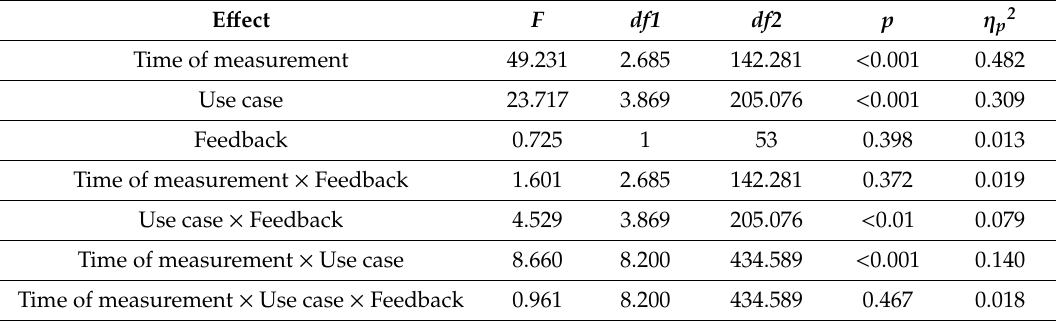
Table 6. Inferential statistics (i.e., F , df1 , df2 , p , η p ² -value) of perceived ease of use.